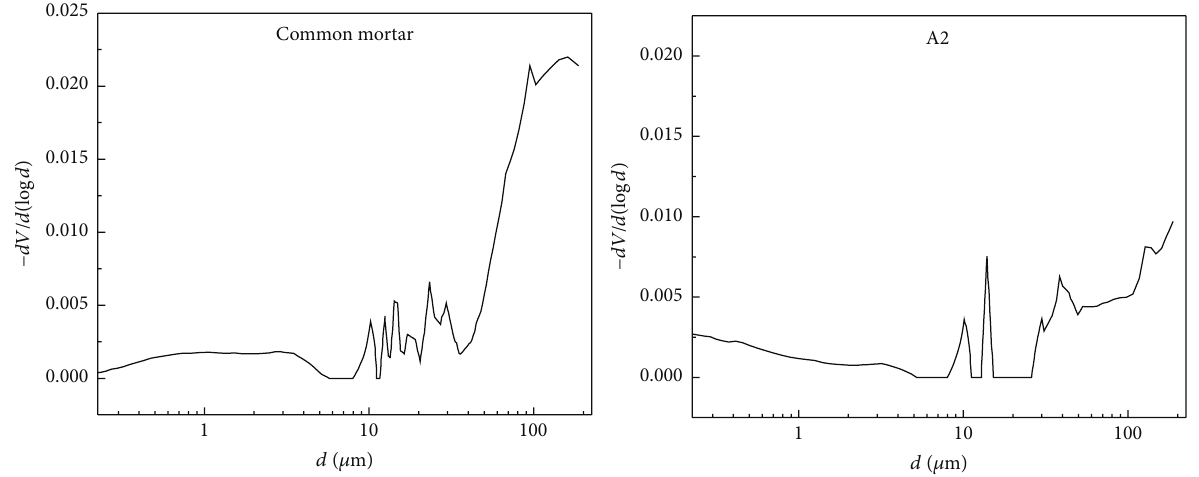
Figure 8: Pore diameter distribution of hardened pastes ( 𝑇 = 28